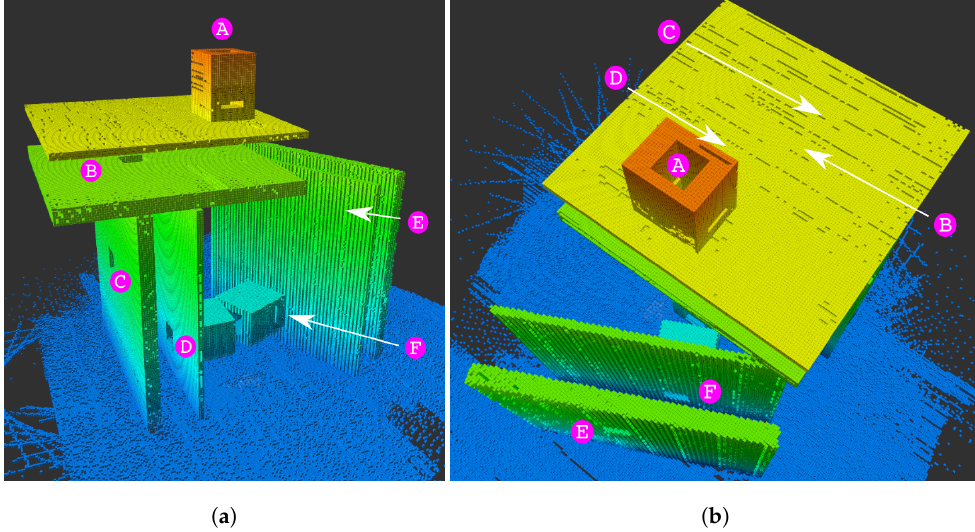
Figure 2. Octomap of the synthetic scenario: a three-dimensional puzzle. This synthetic map showcases the three-dimensional planning potential of Lazy Theta*. Holes in the obstacles are denoted by letters. The resolution of the map is 0.5 m such that the smaller cubes have 0.5 m edges. ( a ) Front view of the structure. ( b ) Top-down view of the